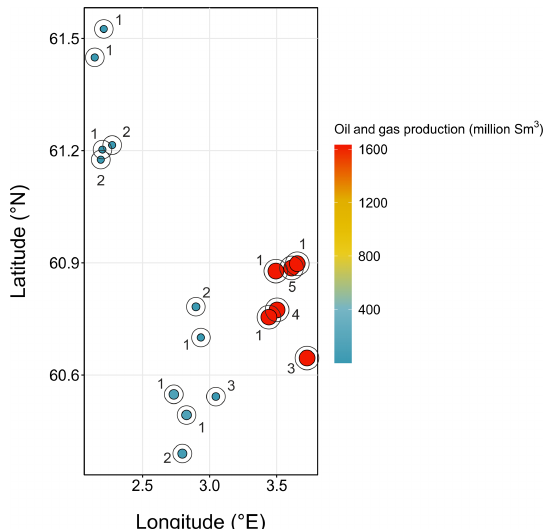
Figure 2. Location of the offshore O&G facilities sampled by the Scientific Aviation aircraft. Each platform is coloured and sized according to respective O&G production for 2019 (Norwegian Petroleum Directorate, 2021). Circles around each platform are used to illustrate the concentric flight laps conducted by the Sci- entific Aviation aircraft during sampling, with the numbers denot- ing the number of times each facility was surveyed. Sm 3 refers to standard cubic